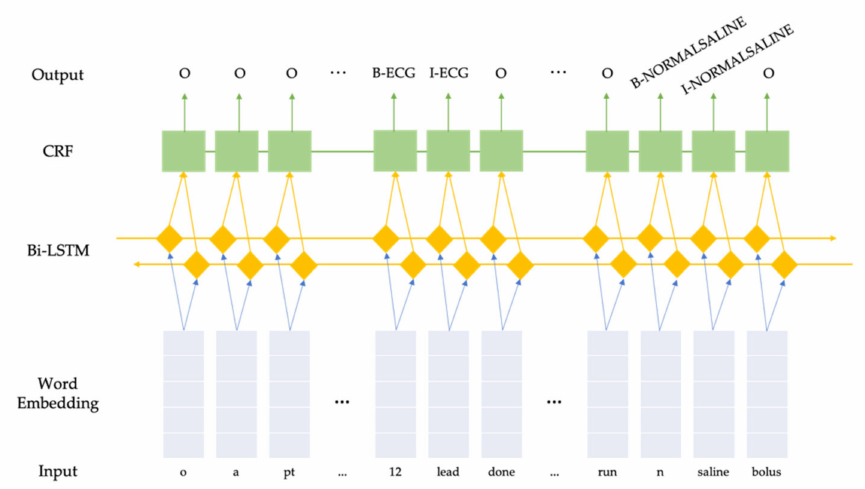
Figure 1. Illustration of our BiLSTM-CRF